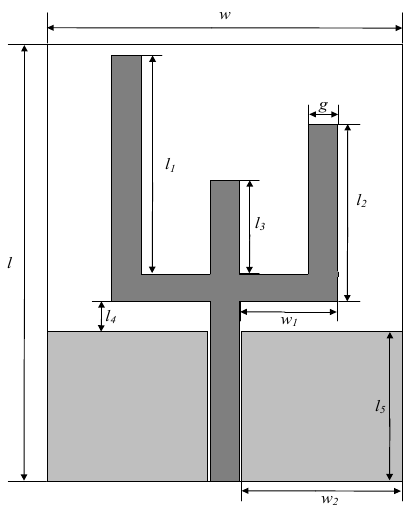
Figure 8. Geometry of the planar multiband antenna. Table 1. Initial Ranges of Design Parameters.